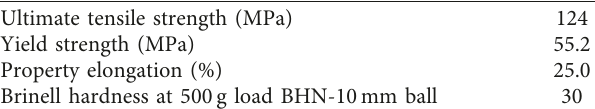
Table 3: Mechanical properties of A6061.